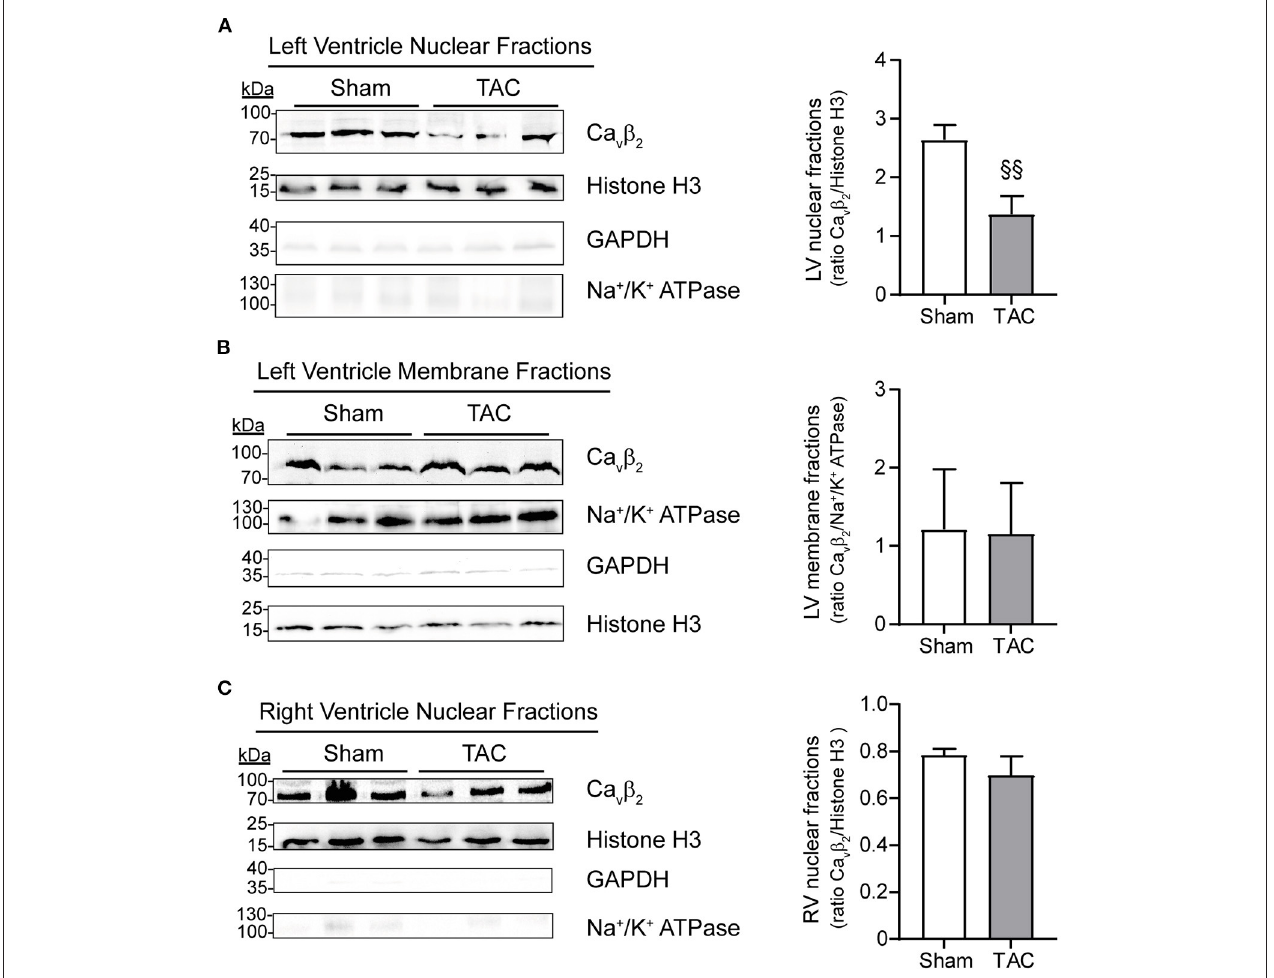
FIGURE 4 | In vivo induction of left ventriclulare hypertrophy produces a decrease in nucleus-targeted Ca v β 2 . Western blot analyses (left panels) and bar plots of mean values of densitometry analyses from western blots (right panels) of: (A) left ventricle (LV) nuclear fractions, (B) LV membrane fractions and (C) right ventricle (RV) nuclear fractions. Per well, 50 µ g of total proteins from sham-operated ( N = 3) or TAC-operated ( N = 3) mice were loaded and detected using an anti-Ca v β 2 antibody. Immunoblots to confirm the presence of the compartment-specific protein markers histone H3 (nucleus), Na + /K + ATPase (membrane) and GAPDH (cytosol) were also performed. Ca v β 2 expression was normalized to histone-H3 (in A and C ) or to Na + /K + ATPase expression (in B). §§ p < 0.05 vs. sham (two-tailed unpaired t -test).